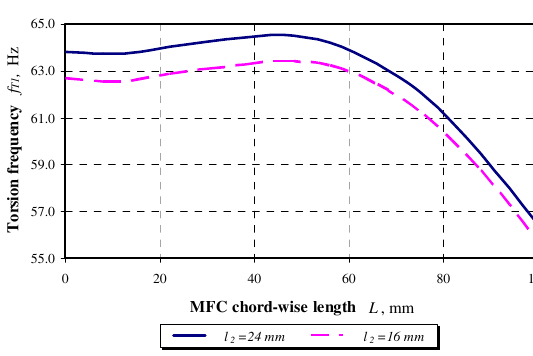
Fig 9. Influence of MFC chord-wise length on mass of cross-section